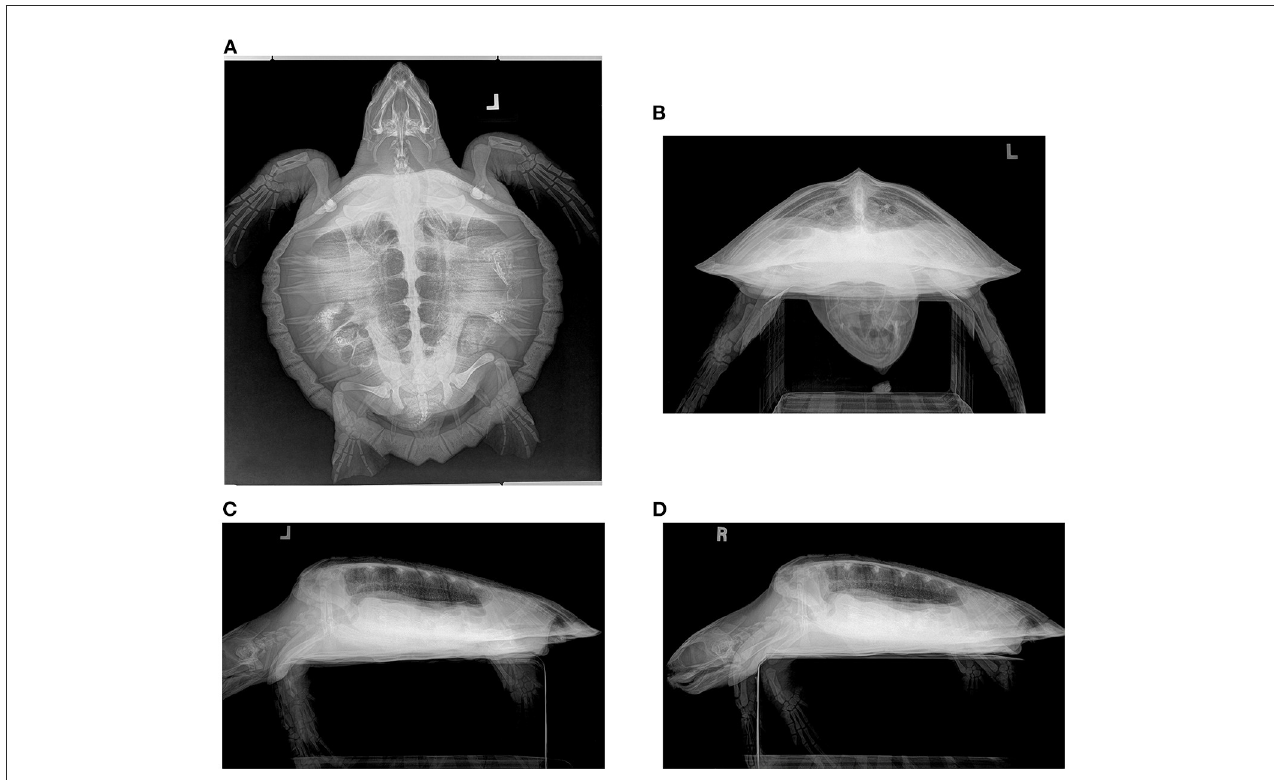
FIGURE1 Radiograph series in a hook-and-line capture but otherwise healthy juvenile Kemp’s ridley sea turtle ( Lepidochelys kempii ). (A) Dorsoventral (DV) projection: The trachea is seen left of the midline in the cervical region before bifurcating in the cranial central coelom. The lung field is seen; however, superimposition of gastrointestinal ingesta and gas present within the gastrointestinal tract limits the full assessment of some regions. The pulmonary artery (lateral) and pulmonary vein (medial) can be seen in parallel coursing through the lung on either side of the bronchus. (B) Rostrocaudal (RoCd) projection: Both lung fields are relatively symmetric making up ∼ 30% of the coelomic cavity. The main stem bronchus is evident in each central lung represented by a thin-walled radiopaque circular structure that is radiolucent in the center. The pulmonary arteries can be seen just dorsal to the main bronchus. Less evident are the pulmonary veins ventral to the main bronchus. (C) Left and (D) Right Lateral Projection: The lung margins are smooth, and the lung fields occupy ∼ 40 ± 10% of the coelomic cavity. The main bronchus is end-on. The pulmonary arteries are dorsal to the main bronchus and the pulmonary veins are ventral, both seen slightly obliquely in this view. On the right lateral projection, gas-distended gastrointestinal loops are seen partially superimposed on the ventral lung